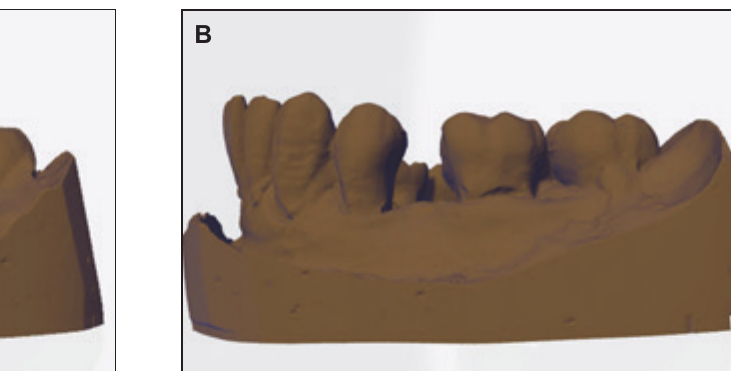
Figure 7. The excessive curve of Spee was flattened after treatment. A. Pretreatment; B.